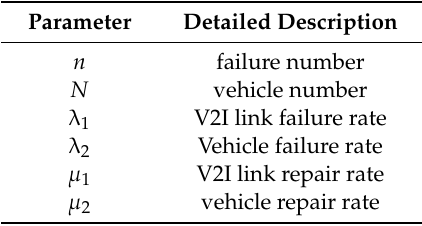
Table 1. Parameter